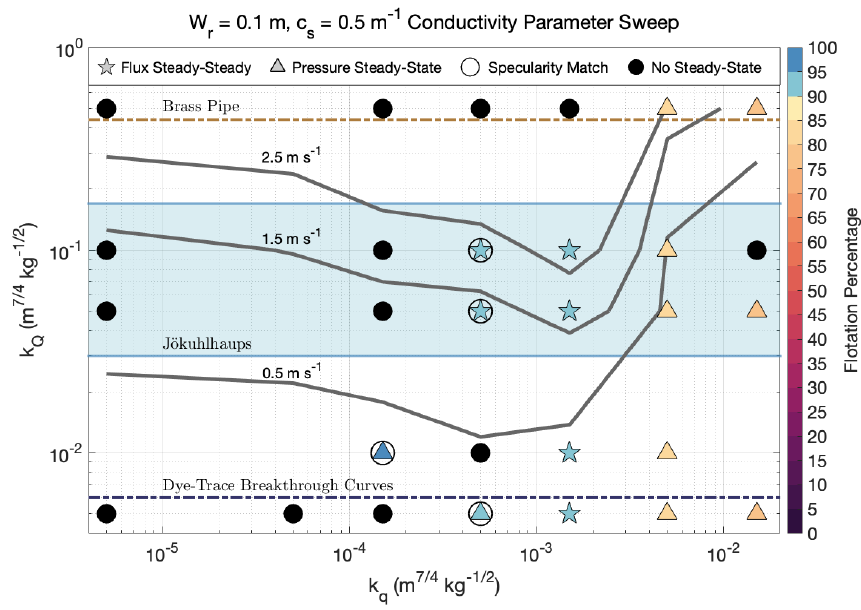
Figure A1. Same as Fig. 4 but for bed roughness parameters W r = 0 . 1m and c s = 0 . 5m − 1 . Stars represent runs that reached flux (and pressure) steady-state, triangles symbolize pressure steady-state simulations, and filled black circles depict runs that did not reach either steady-state criterion. Symbols for steady-state runs are color-coded by the average flotation percentage of grounded ice. Circles around stars or triangles indicate runs that matched observed specularity content and are considered data compatible. Gray lines are 95th percentile channel velocity contours for channels with Q > 5m 3 s − 1 . k Q limits determined from a brass pipe and dye-trace breakthrough curves are plotted as dashed brown and dark-blue lines, respectively, and the blue shaded area represents the typical observed jökulhlaup k Q